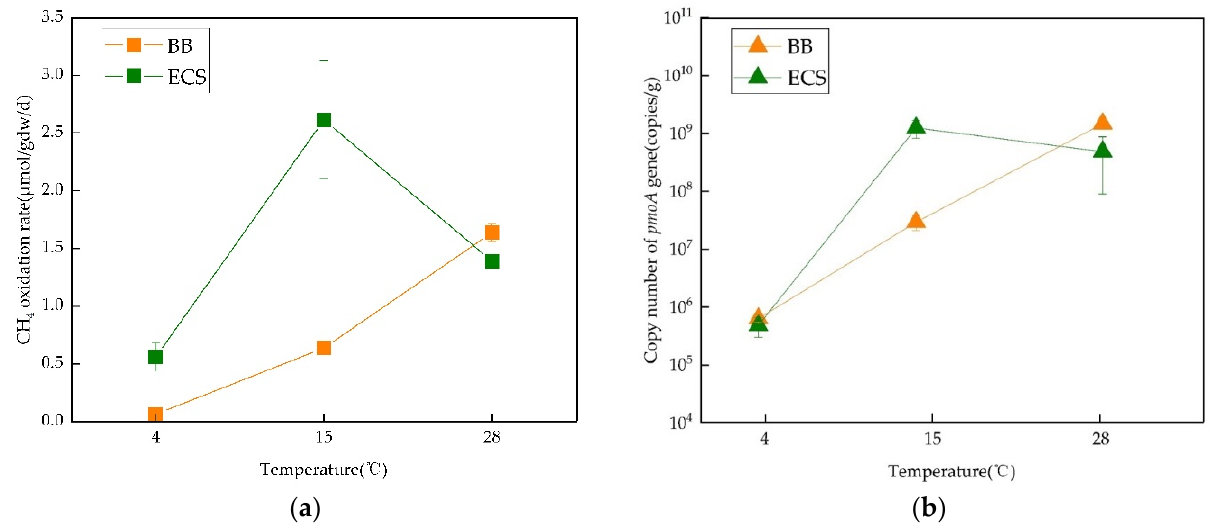
Figure 4. CH 4 consumption over incubation time at different temperatures with BB ( a ) and ECS ( b ) sediments. Values represent means of duplicate incubations ± SD.